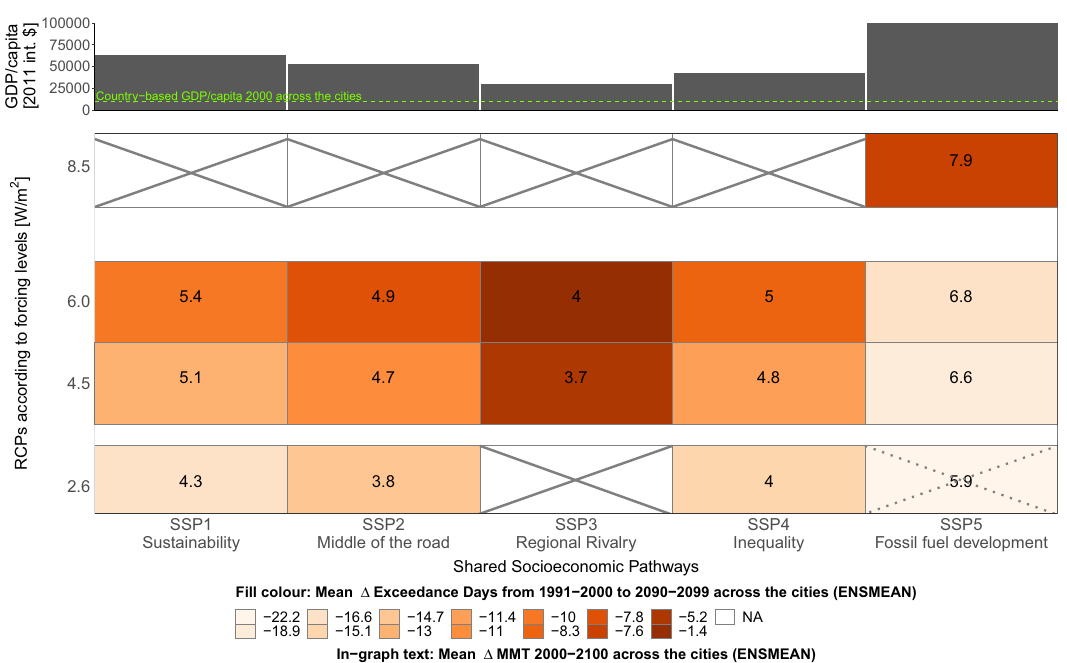
Figure 2. Systematic overview of the change in adaptation and exposure for the city sample according to each RCP/SSP combination and the future socio-economic level per SSP. Lower panel: The 1991–2000 to 2090–2099 (cid:31) EXD (orange boxes) in context of (cid:31) MMT (in-graph text annotations) for all possible RCP/SSP combinations. RCP2.6/SSP5 seems implausible 26 . Parameters of all scenario combinations are presented in Supplementary Table S2. Upper panel: Unique country-based GDP/capita per SSP in 2100 (mean from IIASA and OECD data). Green line in upper panel denotes the country-based GDP/capita as of 2000 [in 2011